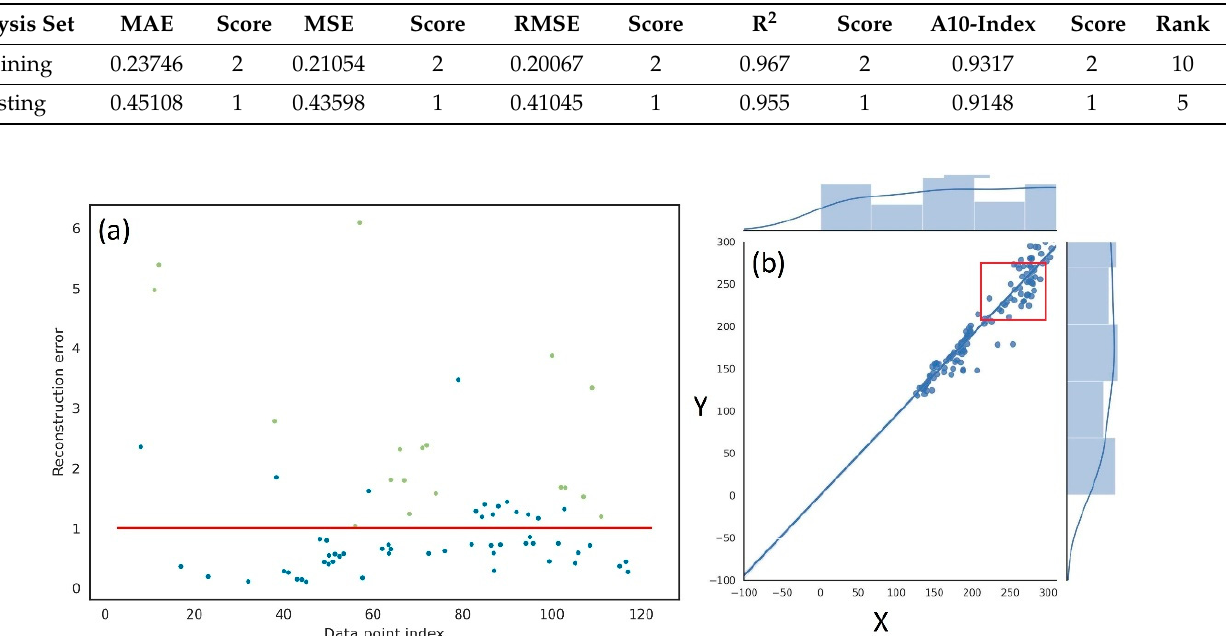
Table 3. Comparison of SVM model performance for Maragheh limestone UCS results.